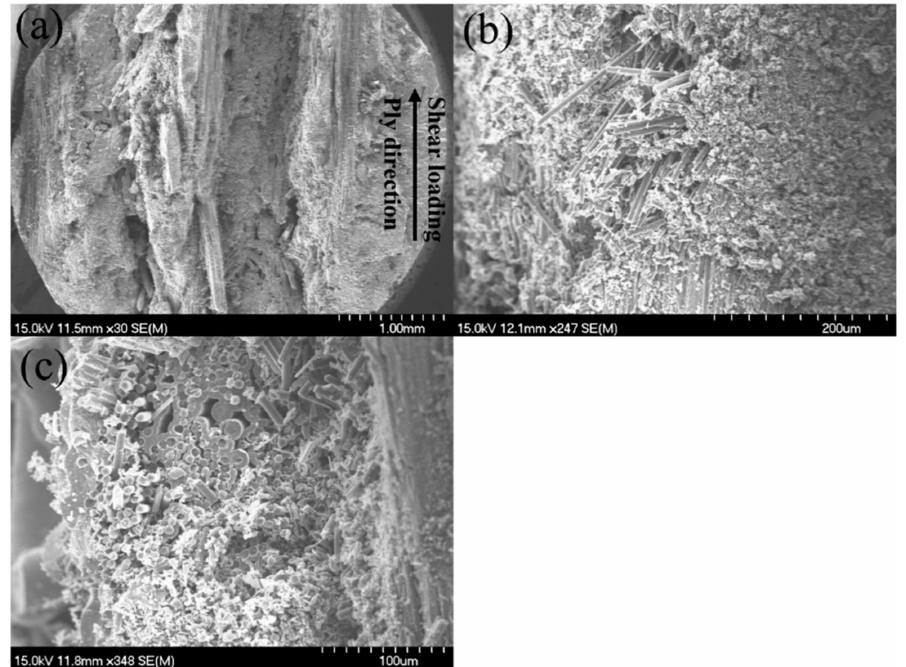
Figure 9. Type II double-shear fracture surface of the 12k T-700 TM MWK–N–C/SiC pin observed under SEM. ( a ) fracture surface; ( b ) fiber pullout in different plies; ( c ) fiber fracture and